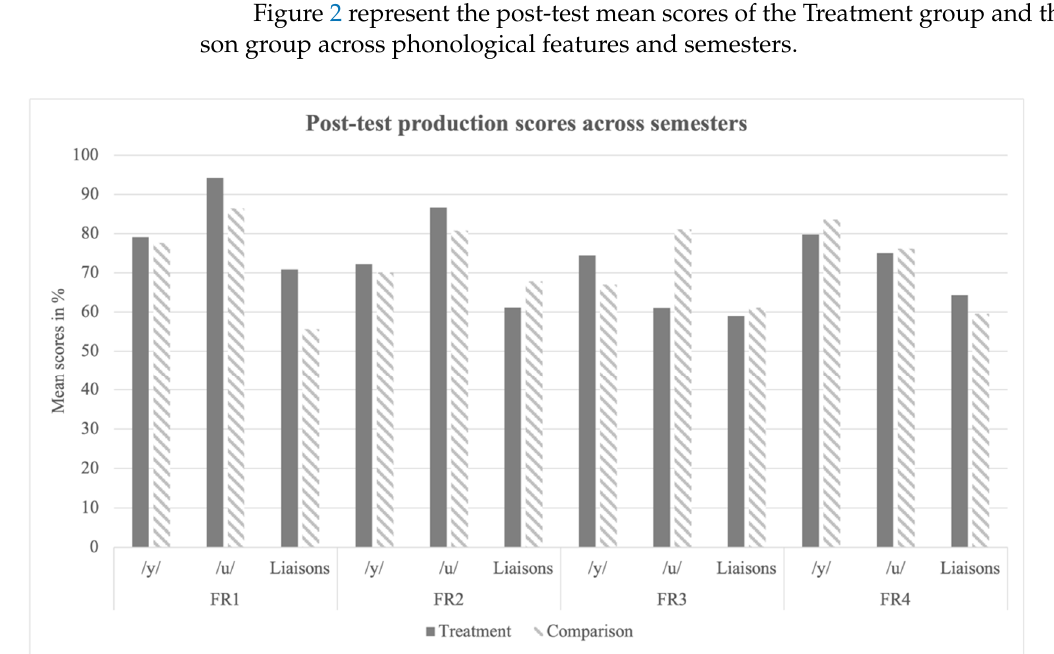
Figure 2. Mean scores on the post-test production tests across four semesters. In FR1, the Treatment group significantly outperformed the Comparison group on the liaisons ( p = 0.038, M T = 70.81, M Cmp = 55.61, d = 0.69) with a medium effect size, and